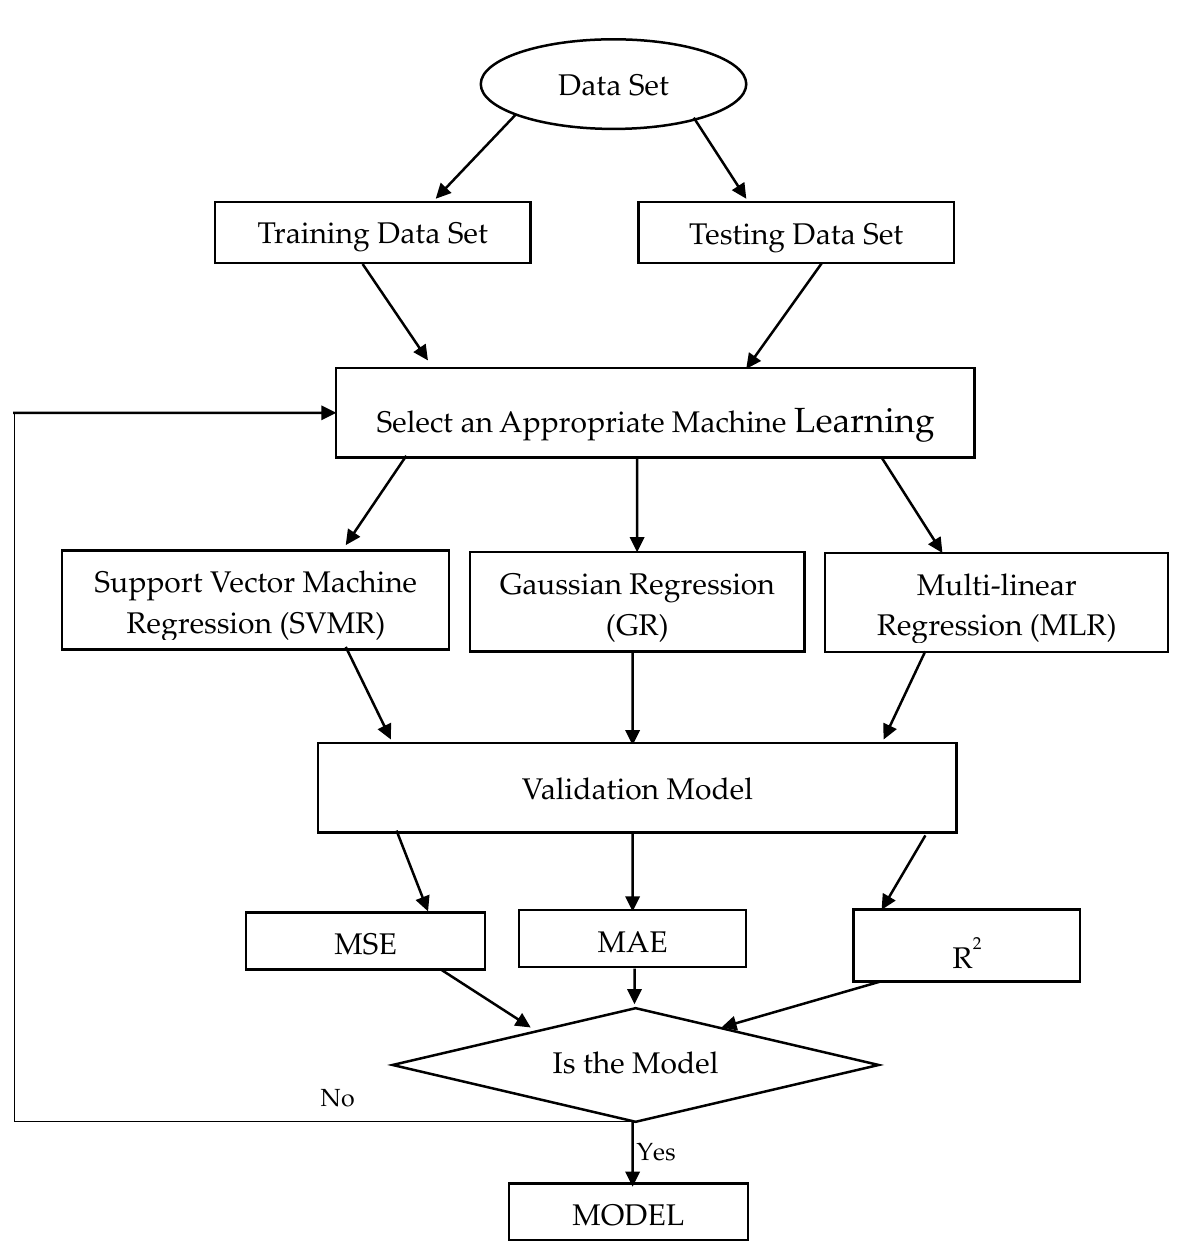
Figure 2. Machine learning workflow for output power prediction.